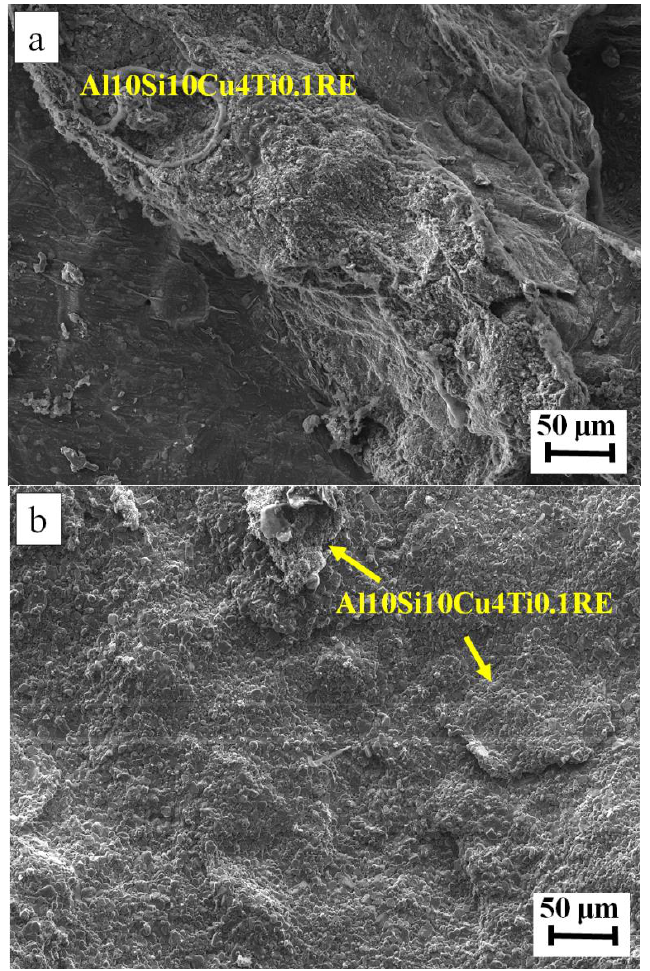
Figure 13. Fractography of the aluminum alloy/alumina joint bonded with the Al10Si10Cu4Ti0.1RE filler alloy: ( a ) AA6061 side and ( b ) alumina side.